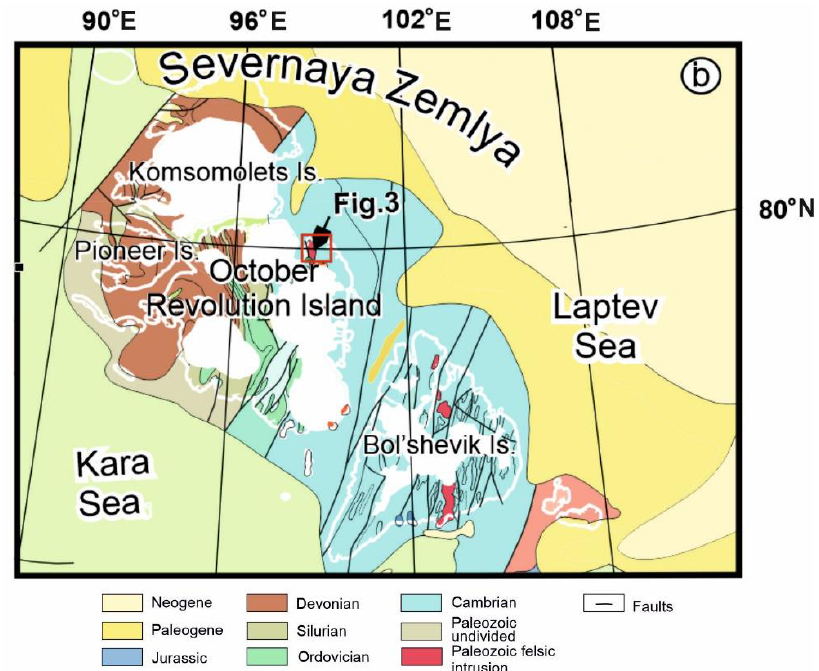
Figure 1. ( a ) Location of the study area [5 – 7]; ( b ) Simplified geological map of the Severnaya Zemlya archipelago (modified after [12,13]).